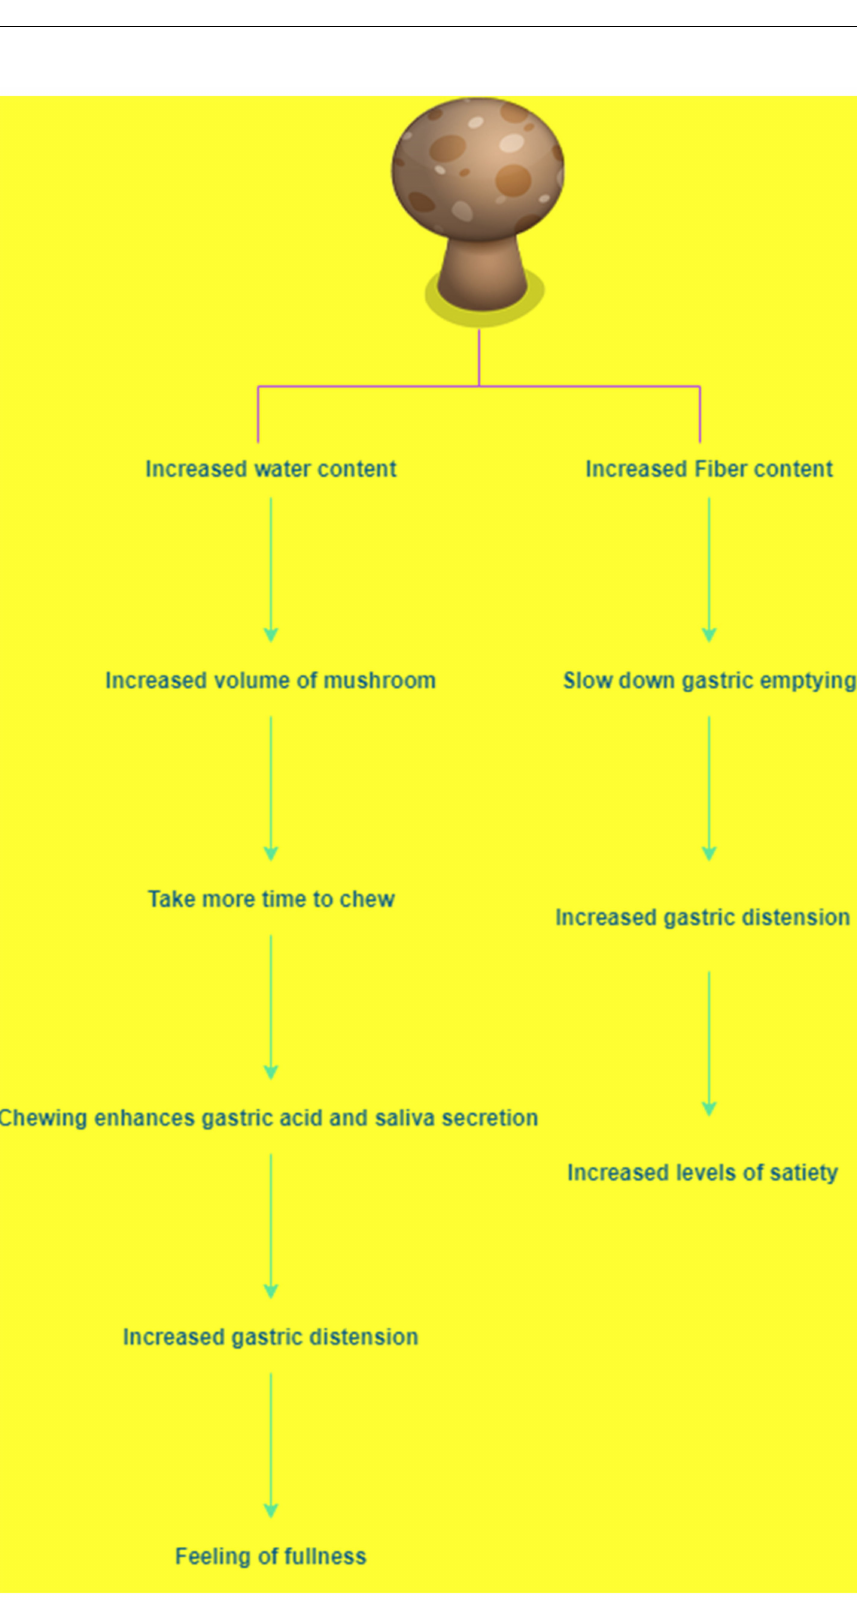
Figure 2. Effect of mushrooms on gastric emptying and salivary